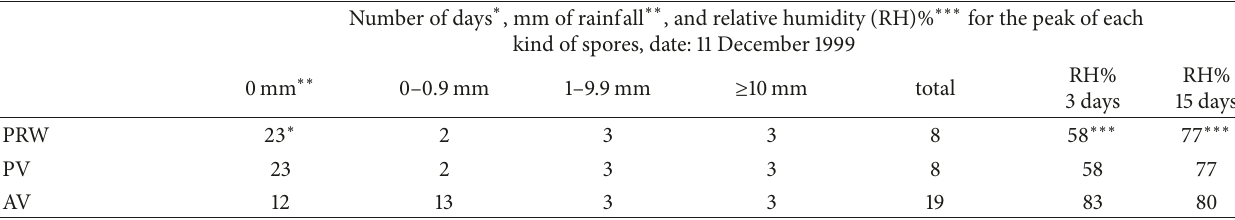
Table 6: Frequency of rain events corresponding to the peak of spores (PRW, PV, and AV) for the second period (1999-2000).